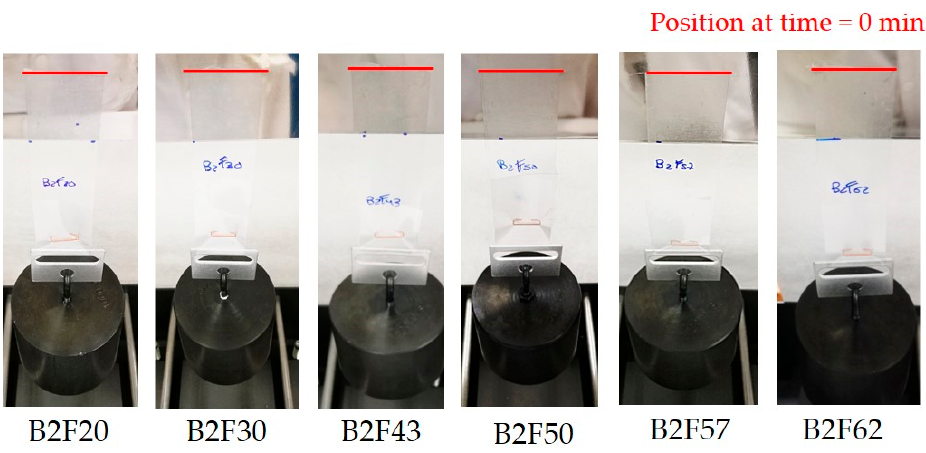
Figure 11. Creep resistance of the EBA copolymer + ECH resin blends after three days.